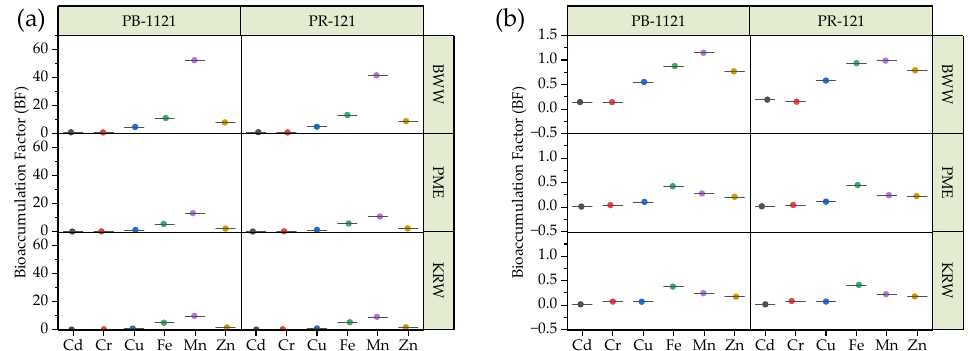
Figure 3. Bioaccumulation factor (BF) of heavy metals in ( a ) straw and (b ) grain of PB-1121 and PR-121 rice varieties irrigated with different water sources in Saharanpur district of Uttar Pradesh, India (BWW: borewell, PME: paper mill effluent, and KRW: Kali River water; the same color dots correspond to values of same heavy metal).